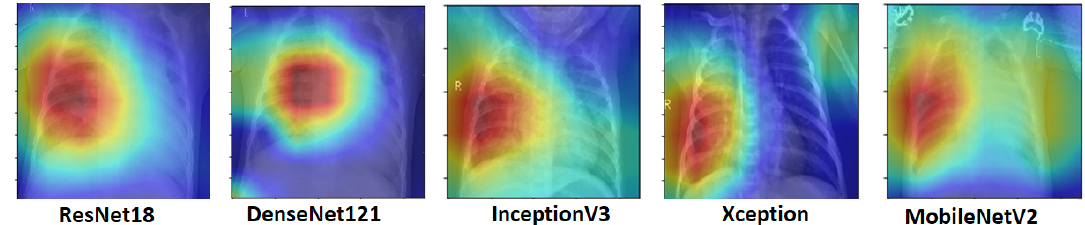
Figure 11. Activation maps for chest X-rays having bacterial pneumonia corresponding to different architectures. Abnormal lungs, in the case of bacterial pneumonia, were detected by the deep learning models.